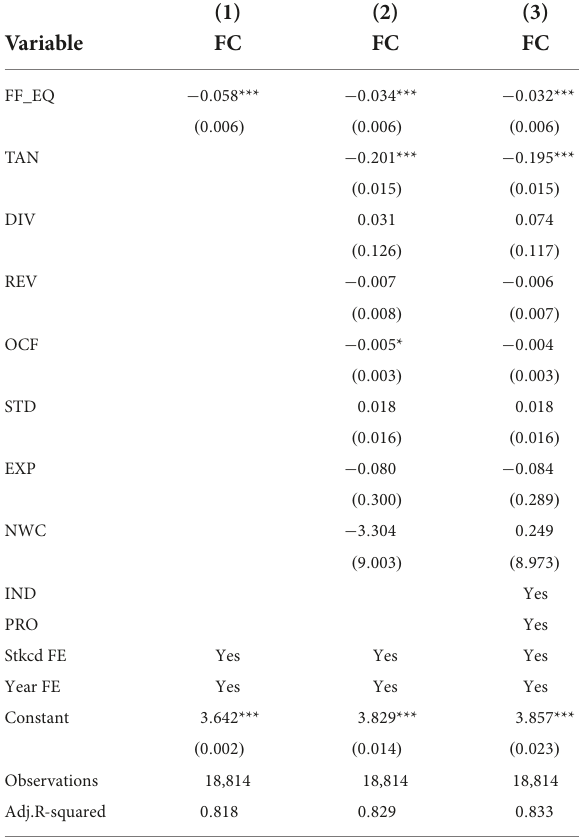
TABLE 8 Robustness test: financial flexibility